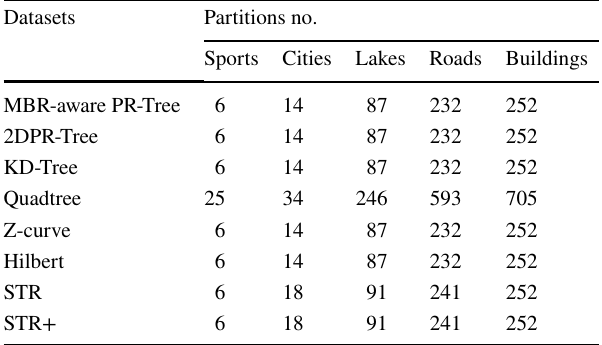
Table 1 Number of partitions by each partitioning techniques Datasets Partitions no.